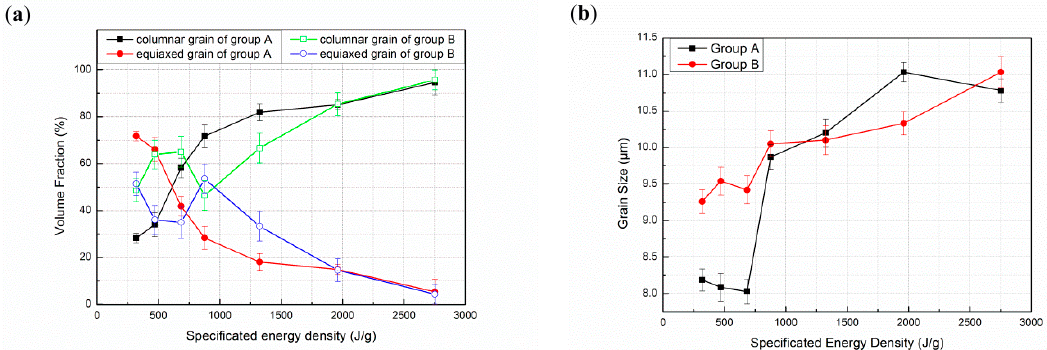
Figure 5. ( a ) The relationship between specific energy density and volume fraction; ( b ) The relationship between specific energy density and grain size.